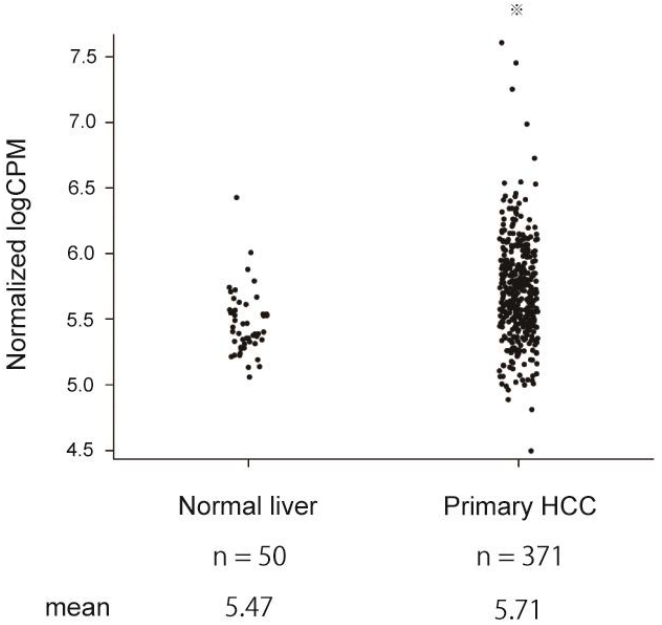
Figure 4. ELAVL1 expression in normal liver and primary HCC in the TCGA database. ELAVL1 mRNA expression based on the dataset obtained from TCGA-LIHC (Student’s t -test, ※ p < 0.05).